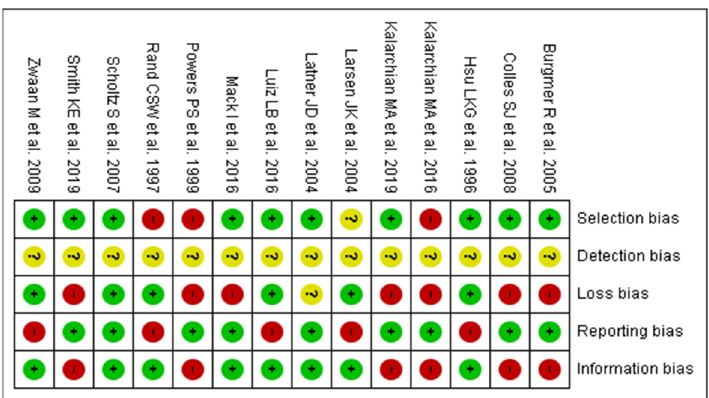
Figure 3. Summary of risk analysis of general articles bias [13–26].